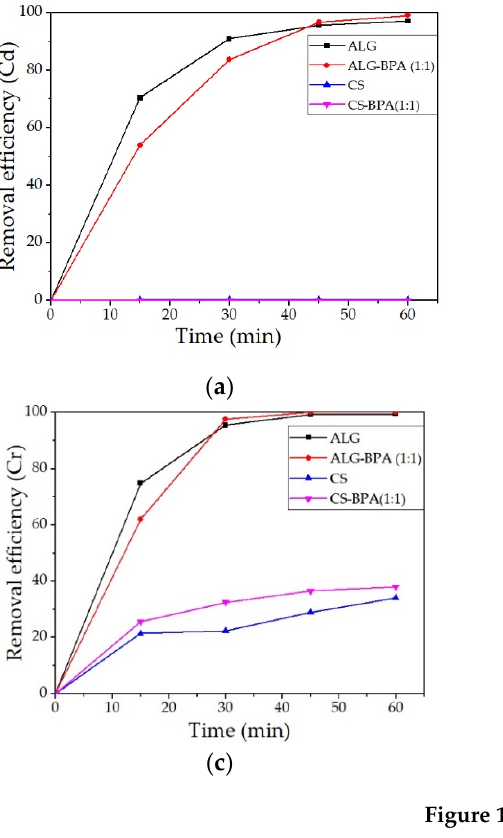
Figure 18. Qualitative analysis on a multielement solution (concentration 0.5 mg/L) for CS ( a ) and CS–BPA (1:1) mi- crobeads ( b ).